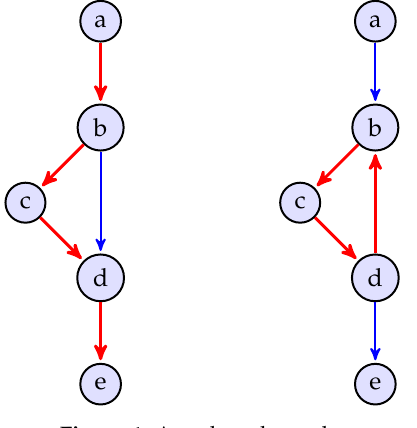
Figure 1. A path and a